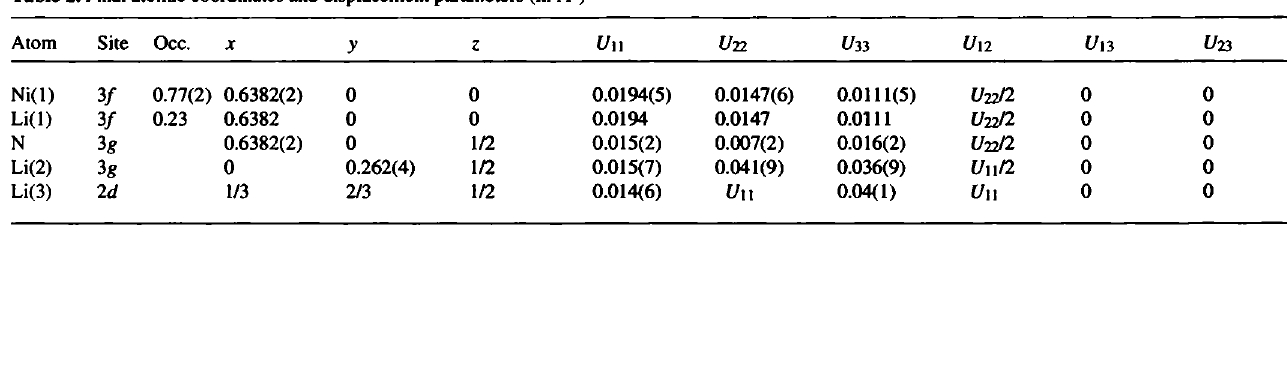
Table 2. Final atomic coordinates and displacement parameters (in Â^)